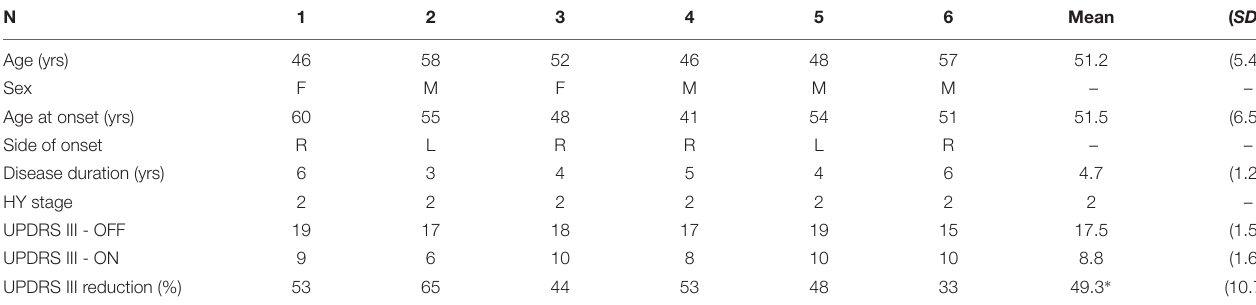
TABLE 1 | Demographic and clinical data of the patients at the time of the MR session.